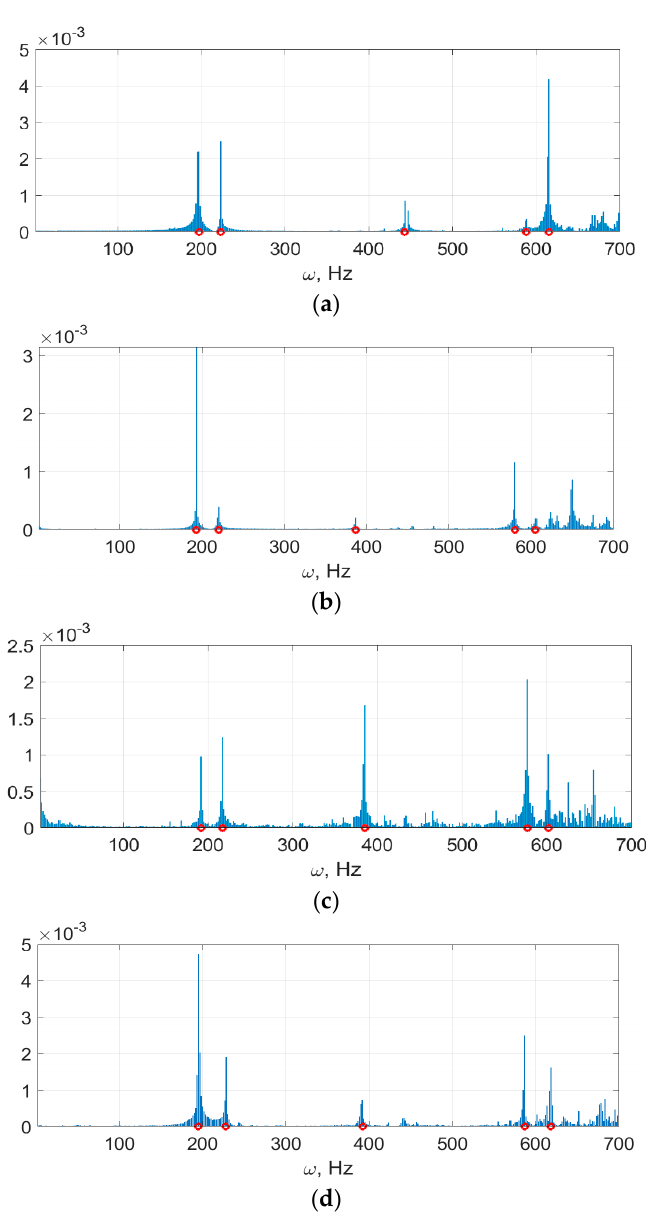
Figure 9. Frequency response functions for initial gaps ( a ) (cid:1833) (cid:2869) ; ( b ) (cid:1833) (cid:2870) ; ( c ) (cid:1833) (cid:2871) and ( d ) (cid:1833) (cid:2872) .